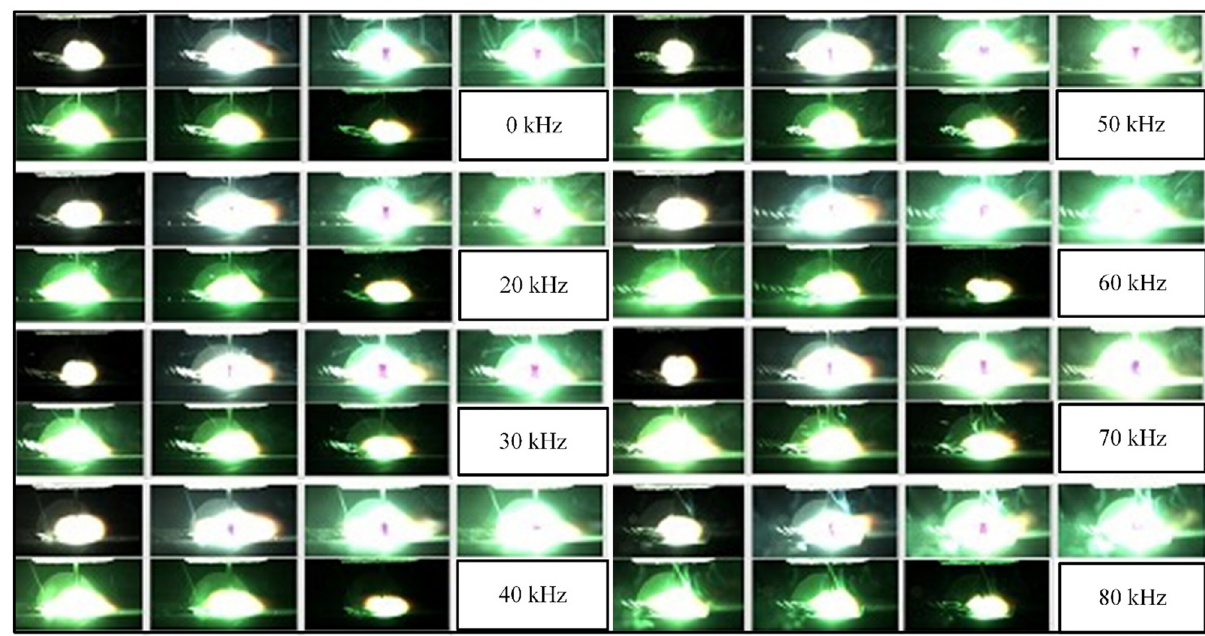
Figure 7: Arc forms at different frequencies.